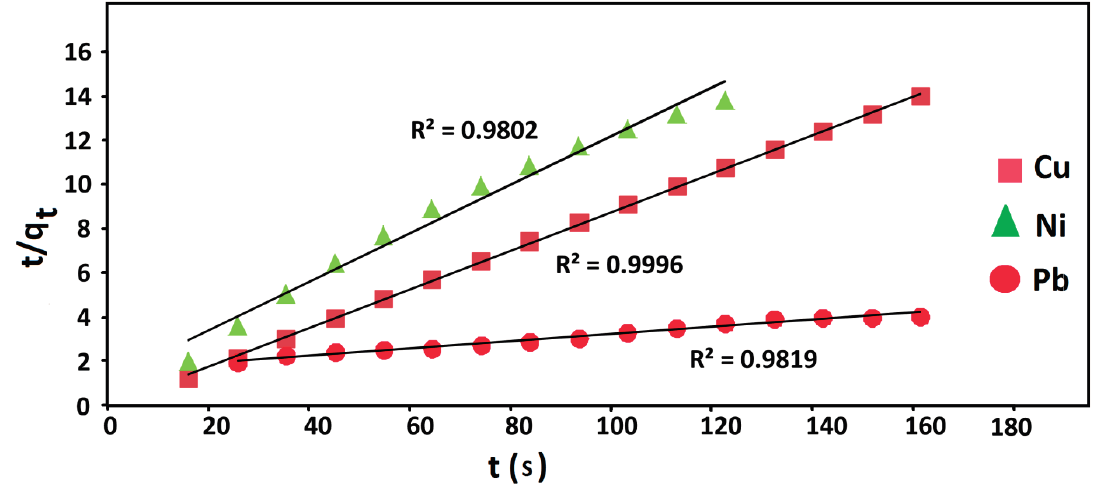
O /talc nanocomposite. 3 4